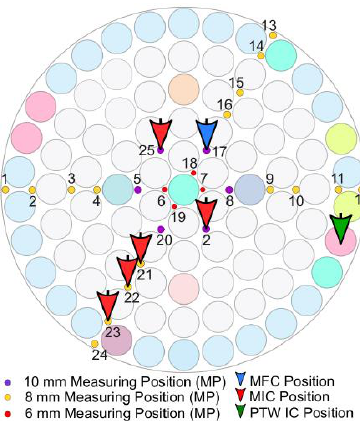
Fig. 2. Measurement positions inside the TRIGA